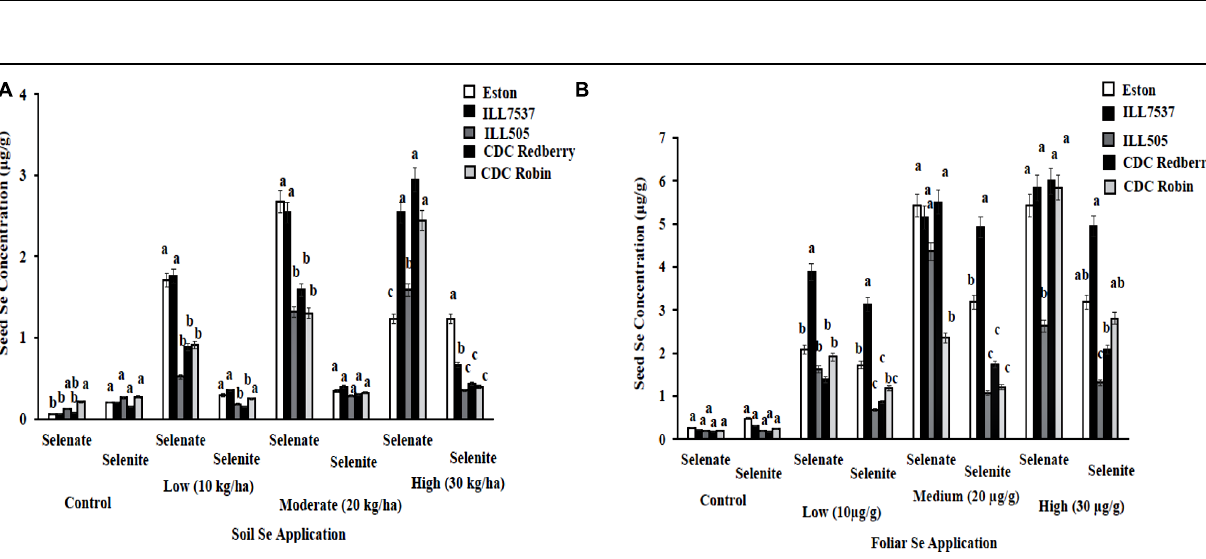
Frontiers in Plant Science |